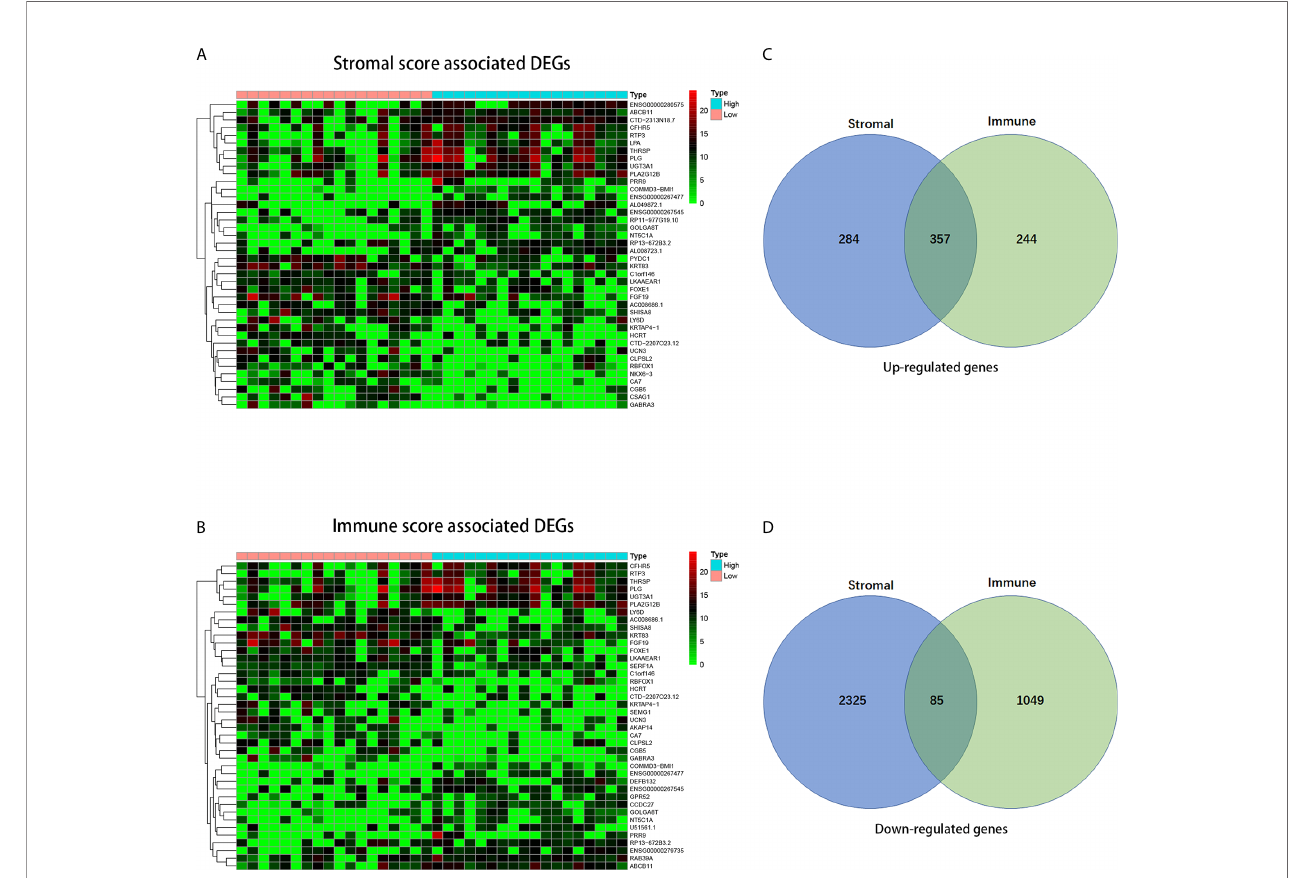
FIGURE 3 | Comparison of gene expression pro fi le with immune scores and stromal scores in cholangiocarcinoma. In accordance with the average linkage method and Pearson distance measurement method, heatmaps were drawn. Red represents higher expressed genes, green represents lower expressed genes. (A, B) Heatmap of the DEGs of immune/stromal scores of left panel (low score) vs. right panel (high score). (C, D) Venn diagrams showing the number of commonly up- regulated (C) or down-regulated (D) DEGs in stromal and immune score